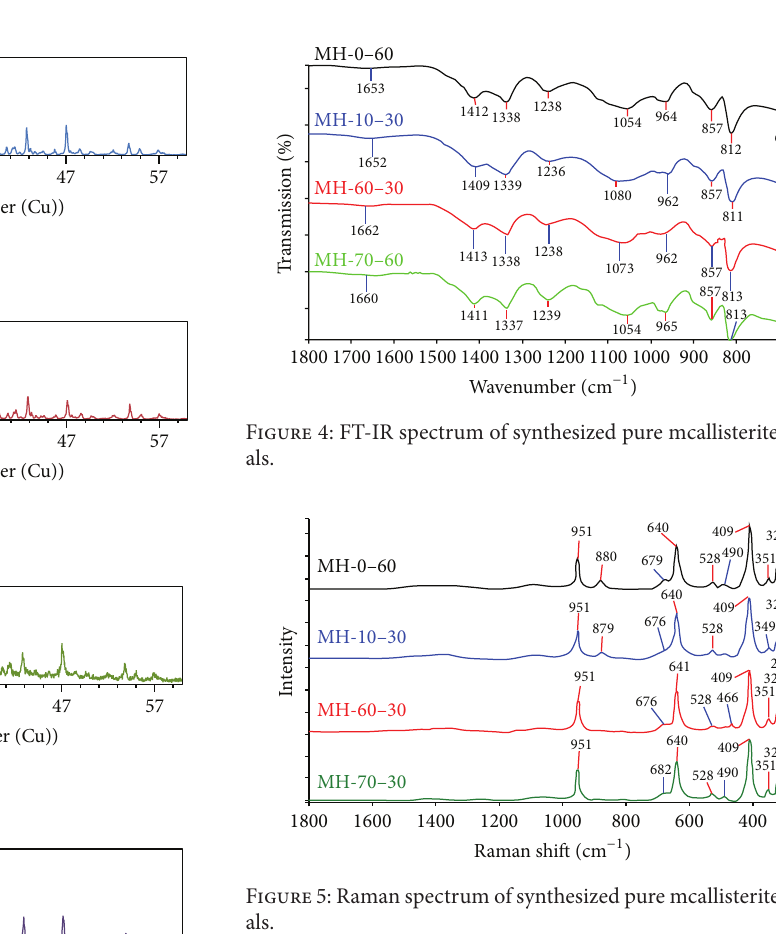
The FT-IR and Raman results are both consistent with the literature [29, 30].